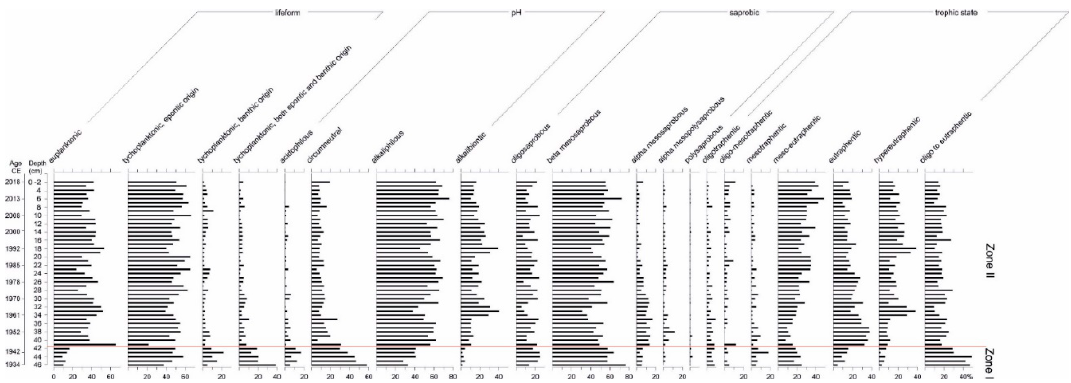
Figure 7. Relative abundance of the diatom group in Lake Sekšu according to habitat category (lifeform), pH, OM contamination (saprobic), and trophy preference.